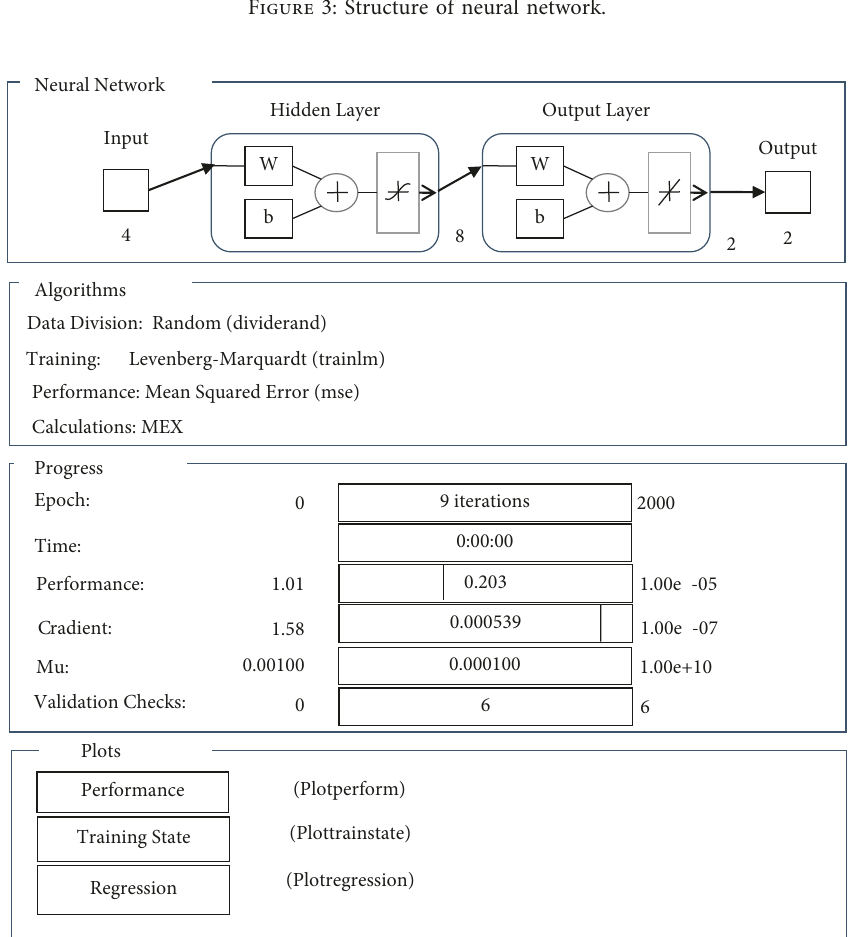
Figure 4: MATLAB neural network training